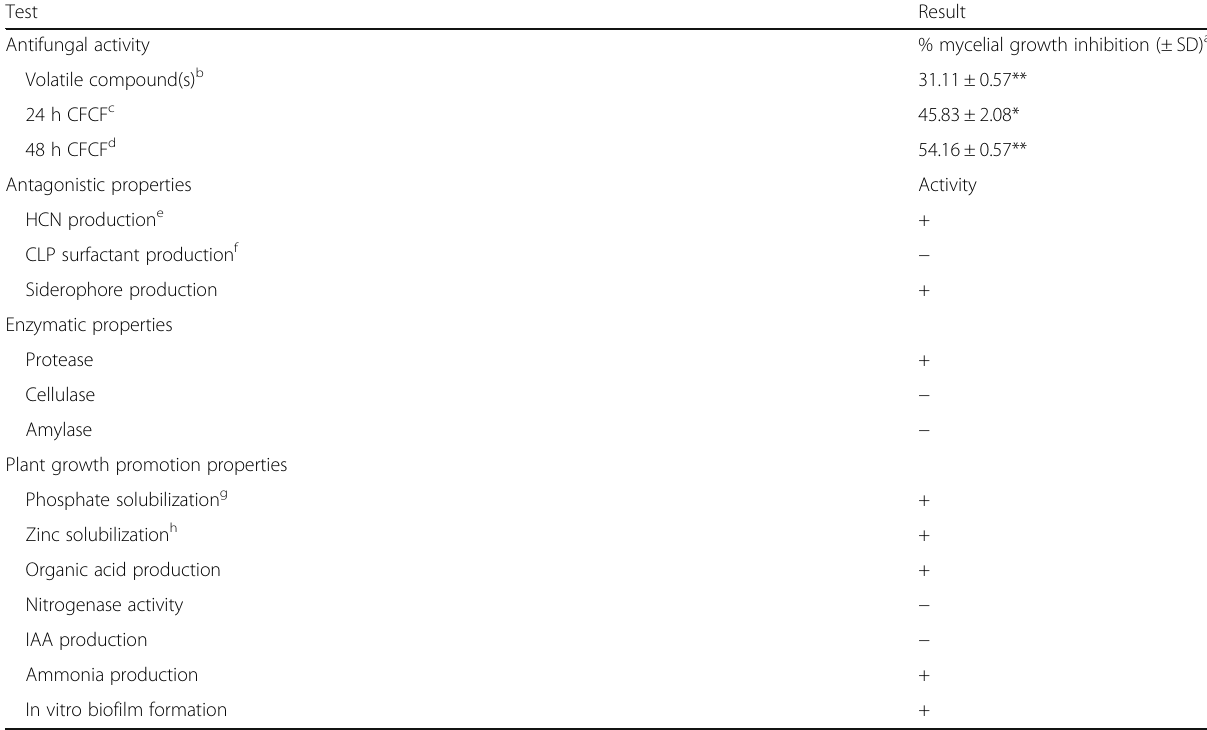
Table 1 Antifungal, antagonistic, enzymatic, and plant growth promoting activity of isolate BA5